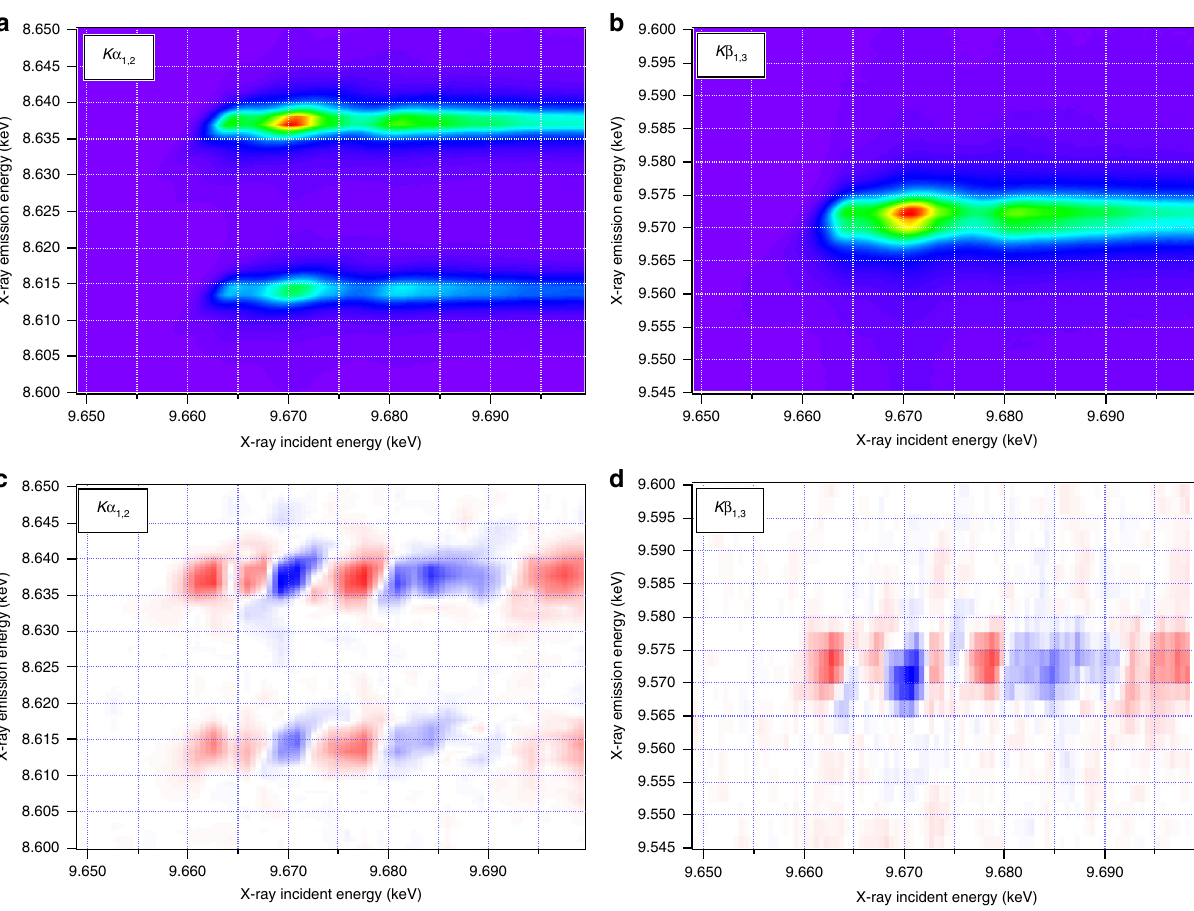
Fig. 4 Ground state and transient K α and K β RXES. The ground state Zn K α ( a ) and Zn K β ( b ) RXES spectra of 32 nm ZnO nanoparticles in aqueous colloidal solution. The transient Zn K α ( c ) and Zn K β ( d ) RXES spectra of 32 nm ZnO nanoparticles in colloidal solution measured 80 ps after photoexcitation at 355 nm with a fl uence of 80 mJ/cm 2 . In c , d , red indicates positive and blue indicates negative